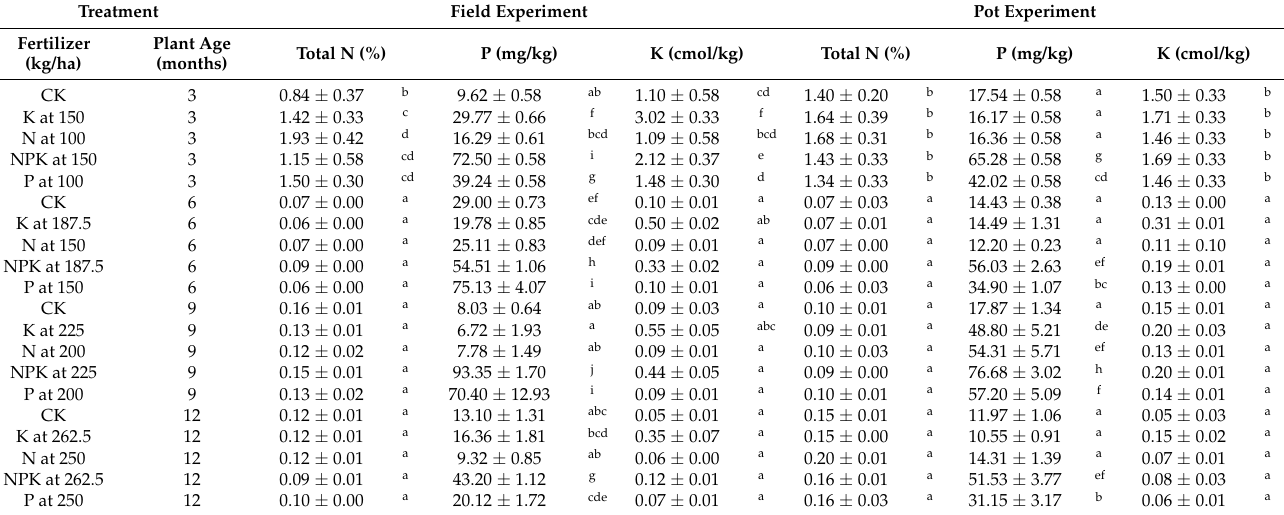
Table 7. Effects of inorganic fertilizer application on soil macronutrients (N, P, and K) levels at the end of the different harvesting